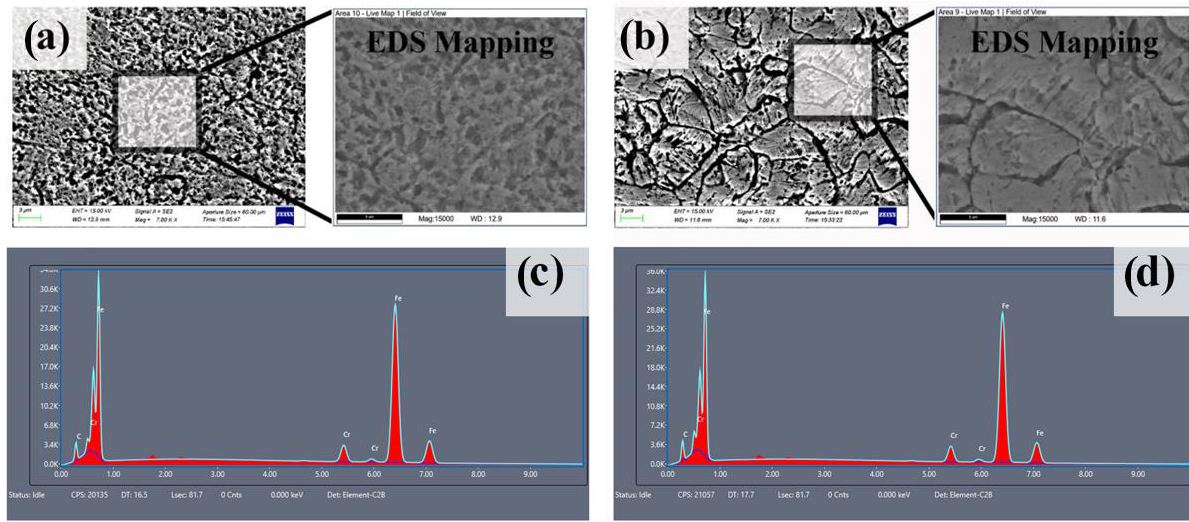
Figure 8. SEM images and EDS mapping results of HAZ: samples with laser power of 2000 W ( a , c ) and samples with laser power of 2400 W ( b , d ).